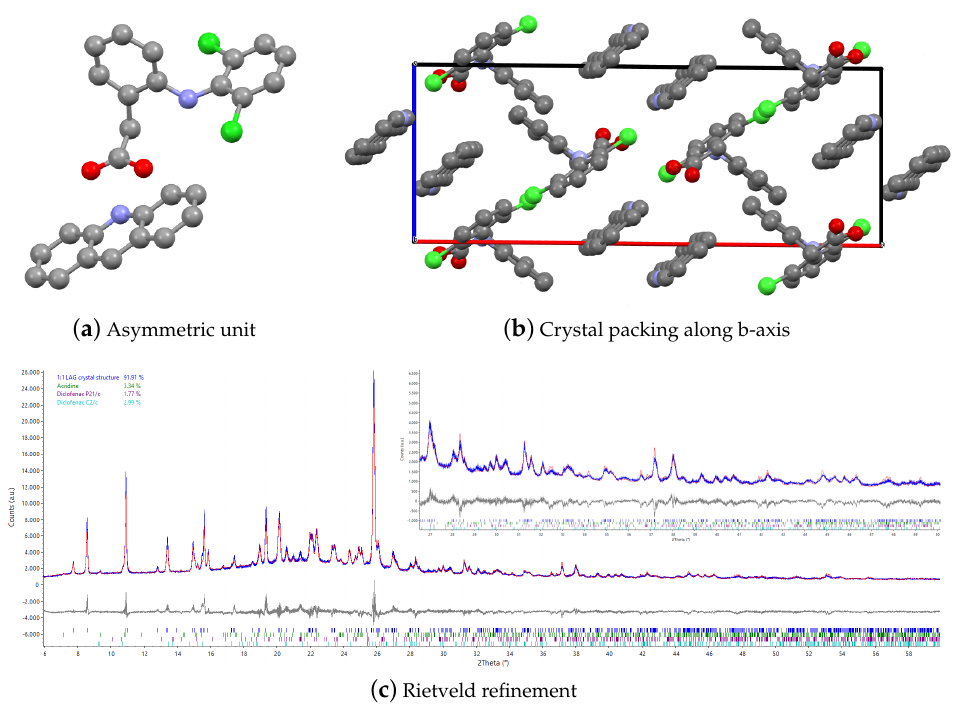
Figure 1. ( Top ): asymmetric unit ( left ) and crystal packing ( right ) of the new cocrystal; ( Bottom ): Rietveld refinement of the new structure.